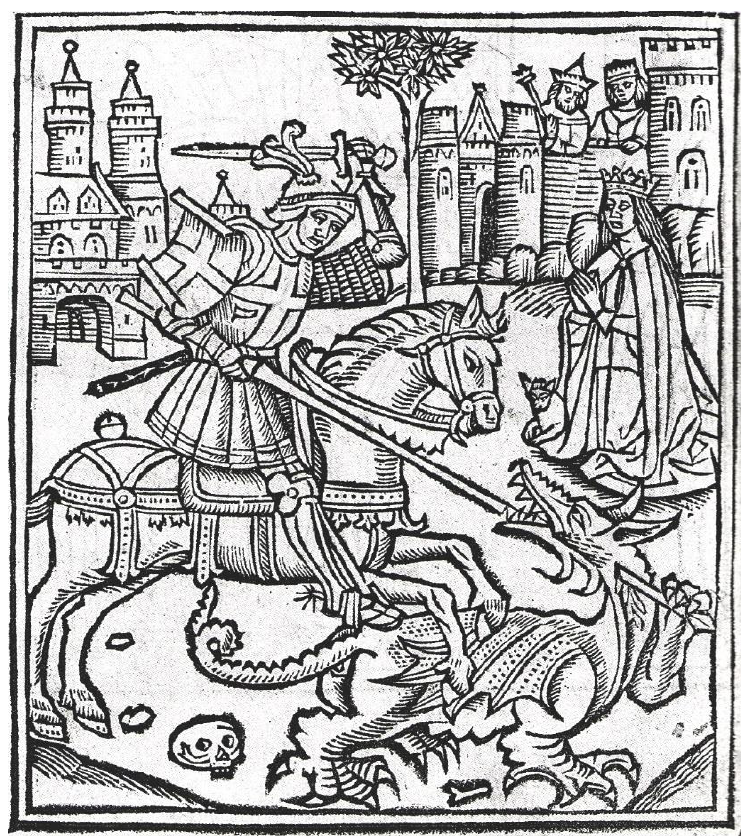
Figure 11. Woodcut of St George and the dragon. Alexander Barclay, Life of St George (London: Richard Pynson, 1515) frontispiece .